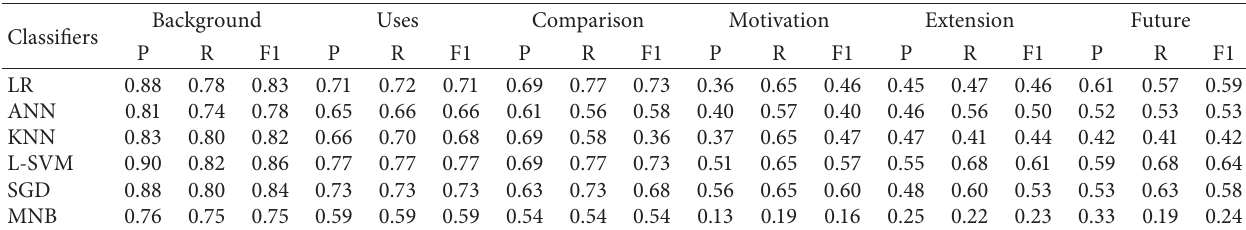
Table 7: Comparison of precision, recall, and F1 score of various classifiers using the ACR-ARC dataset.